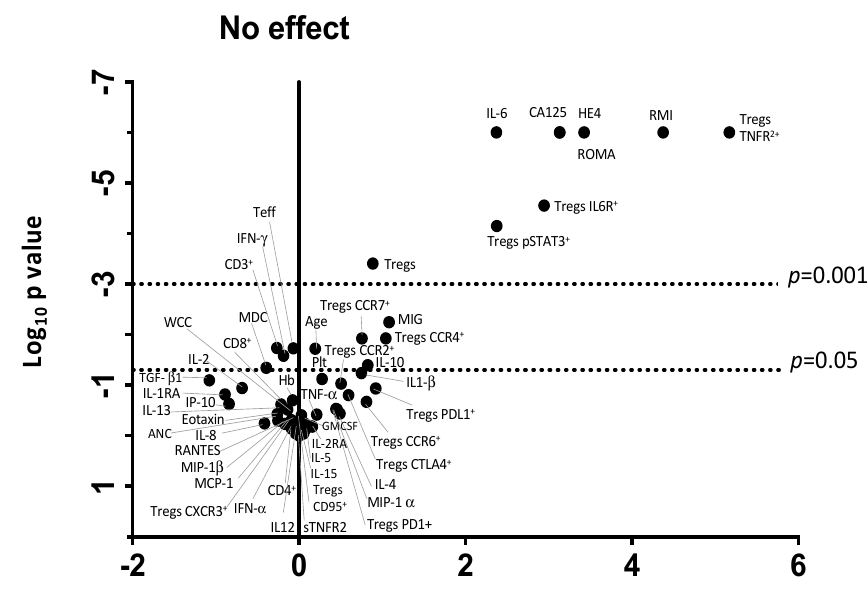
Figure 2. Principal component analysis (PCA) of serum soluble factor levels and T cell phenotypic markers to identify immune factors that are predictive of malignancy. Pre-treatment blood was withdrawn from 66 patients: 33 patients with ovarian cancer, 12 benign ovarian mass and 21 with normal ovaries. A total of 28 serum soluble factors were measured using multiplex bead immunoassay and 16 phenotypic markers (surface and intracellular) on regulatory T cells (Tregs) and effector T cells (Teff) were identified and quantified by flow cytometry. Demographic data, serum CA125, HE4 and blood components were included in the analysis. ( A ) Data reduction was conducted using principle component analysis. The clusters of immune markers with reliable predictive accuracy (values of diagnostic parameters above 0.5) were labelled as components 1 (black dots). ( B ) Component scores were applied to individuals in the study according to their disease categories.